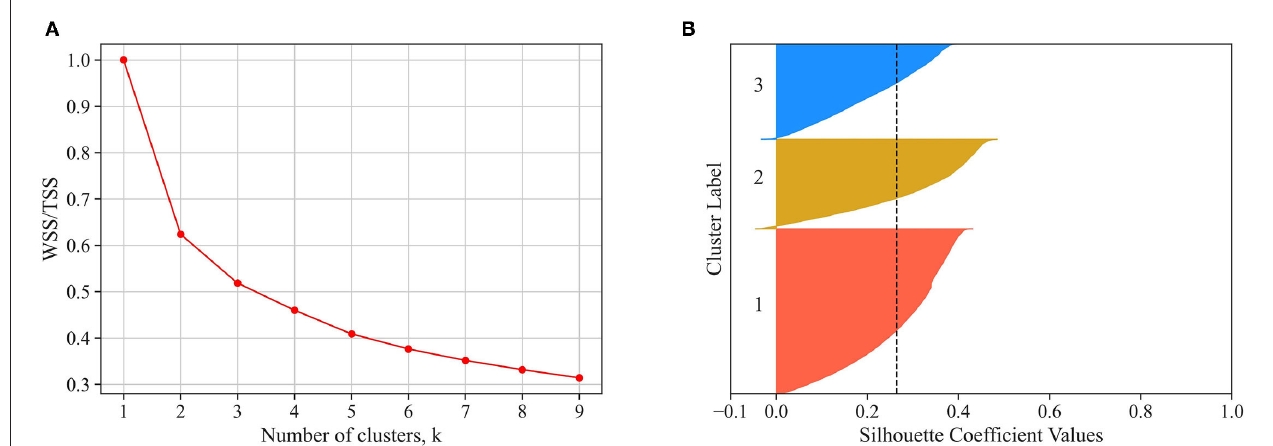
FIGURE 4 | In (A) , the ratio of within sum of squares (WSS) to the total sum of squares (TSS) is displayed as a function of the number of clusters. The elbow plot suggests selecting three clusters since adding an additional cluster does not substantially increase the explained variation. In (B) , the Silhouette coefficient value of each observation is displayed for the three-cluster solution (i.e., for each cluster, the observations are ordered by their Silhouette coefficient value and displayed in ascending order as horizontal stacked lines). The average silhouette score is reported (dashed line). The three clusters have predominantly positive scores, suggesting valid